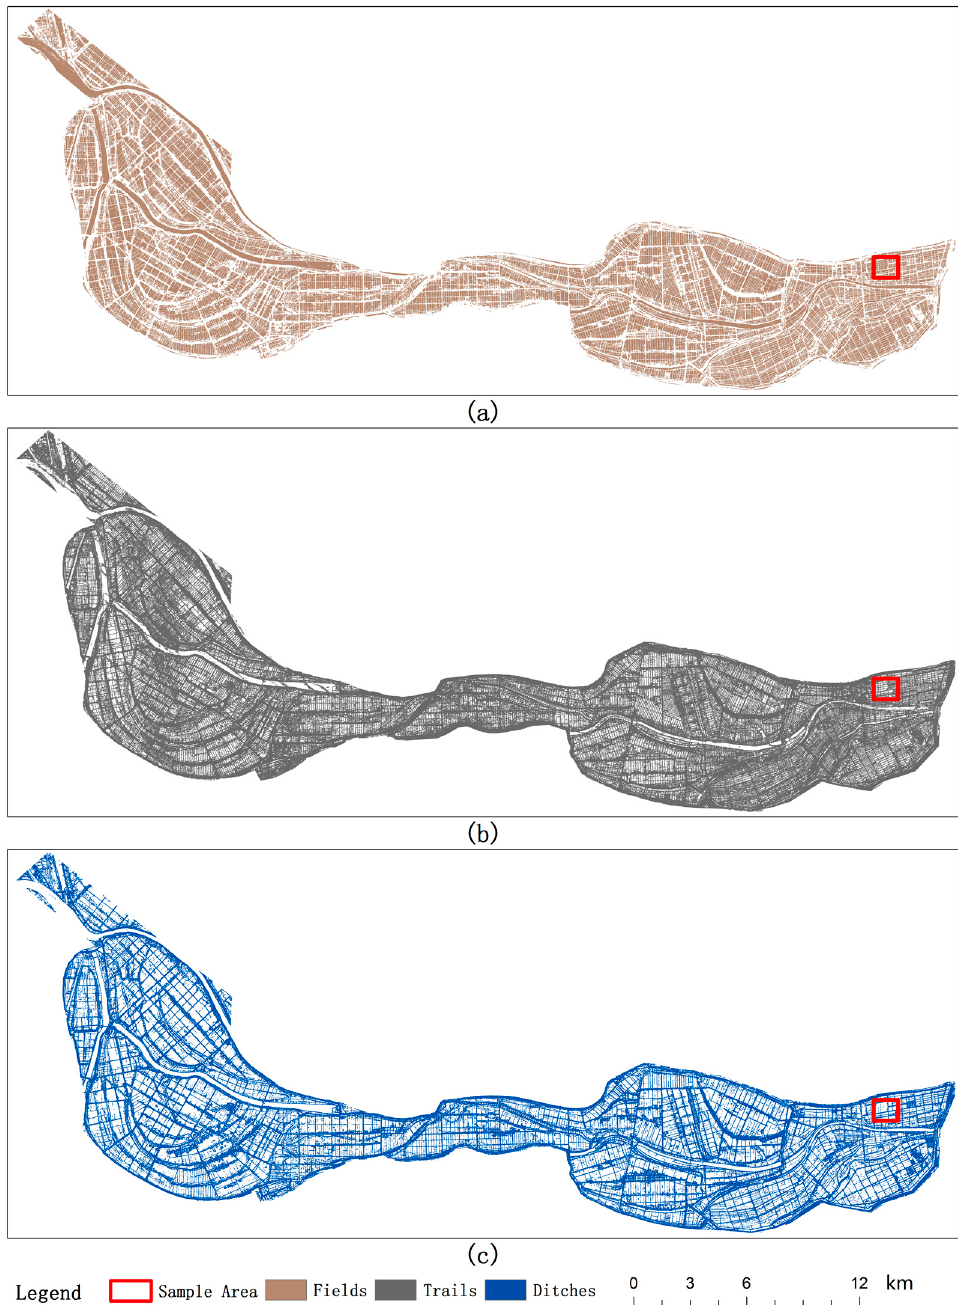
Figure 11. Vector results of the entire research area: ( a ) fields, ( b ) trails, and ( c ) ditches.